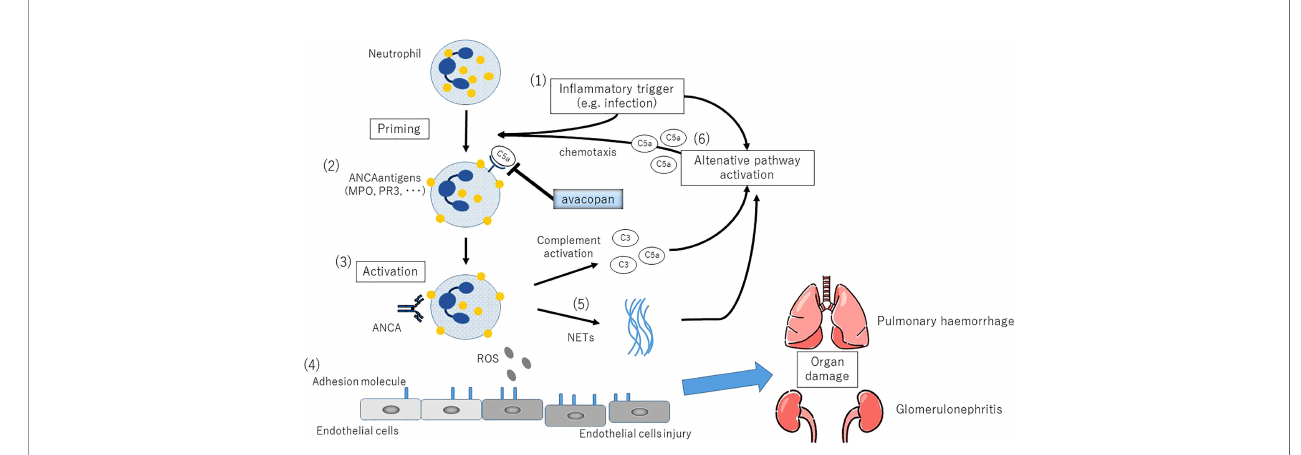
FIGURE 2 | The complemental alternative pathway(cAP) in the etiology of ANCA-associated vasculitis. (1)In fl ammatory stimuli such as respiratory tract infections induce neutrophil priming via secretion of TNF and other proin fl ammatory cytokines. (2)Translocation of PR3 and MPO, the counterpart antigens of ANCA, on the neutrophil cytoplasmic membrane. Plasma ANCA becomes accessible to neutrophils. (3)Activation of neutrophils by ANCA. (4)Increased expression of adhesion molecules in small vessels leads to endothelial adhesion, followed by vascular destruction by ROS production and release of degradative enzymes. (5)NETs (neutrophil extracellular traps) production, the persistence of autoantigen presentation, and the production of cAP activating factors. (6)C5a generated as a result of cAP activation promotes local migration and priming of neutrophils, further amplifying this